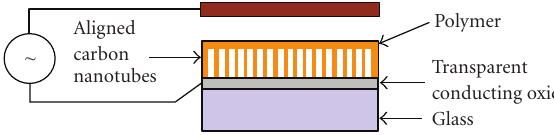
Figure 8: Alignment of carbon nanotubes by an electric field.